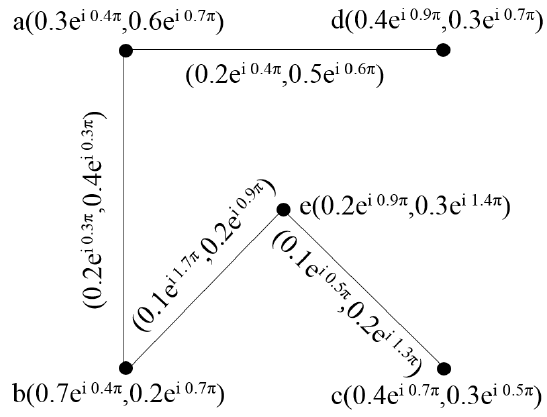
Figure 12. Complex intuitionistic fuzzy graph of G .